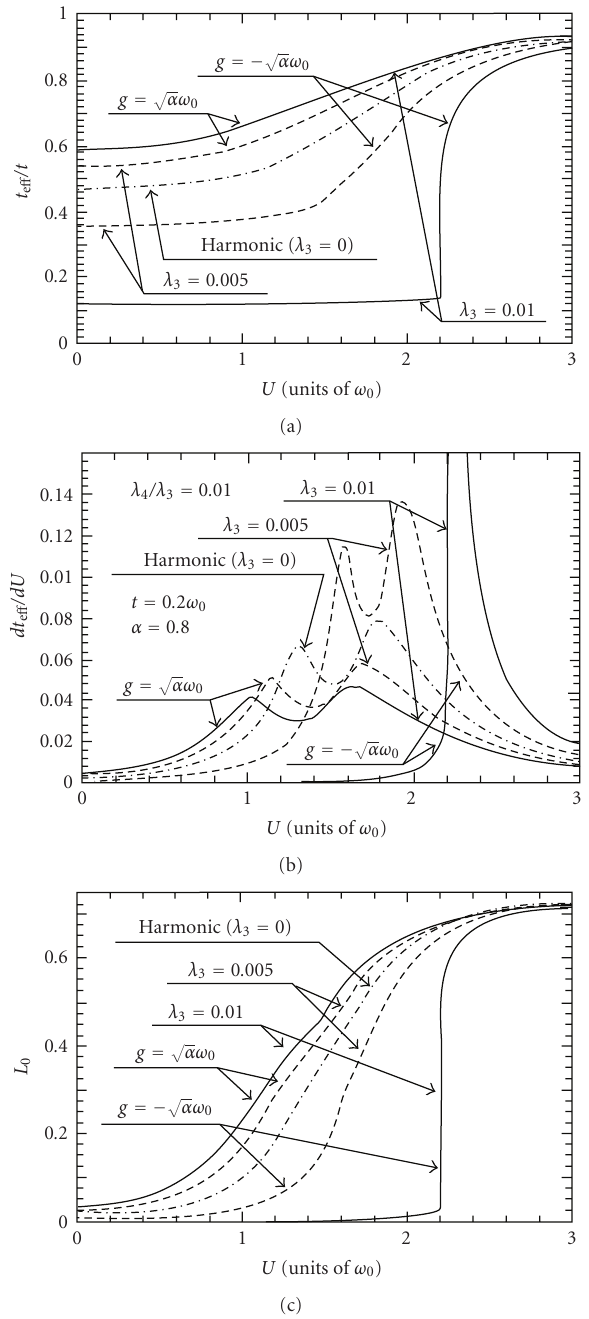
Figure 7: Plots of (a) the renormalized hopping integral, (b) the derivative of the renormalized hopping integral with respect to U , and (c) the local spin moment as a function of U .